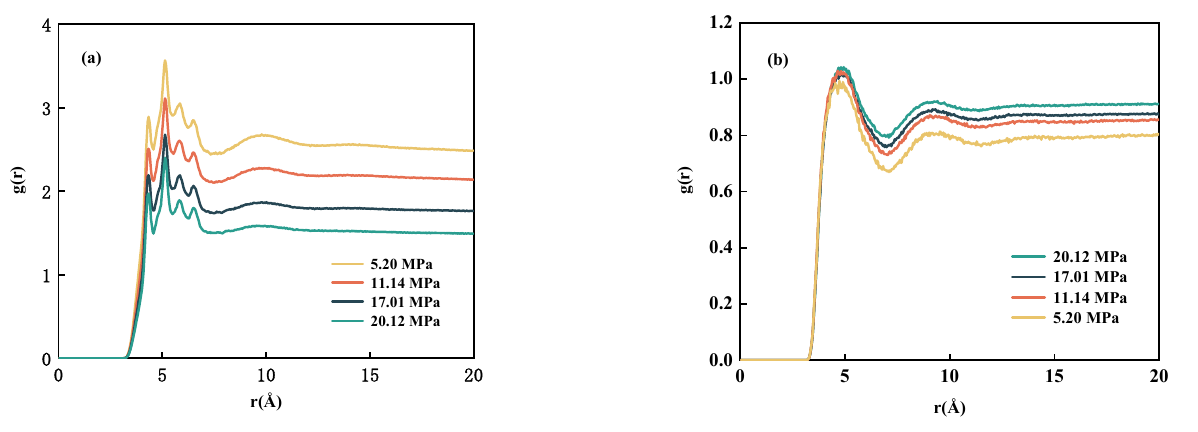
Figure 11. Radial distribution function of n-decane/CH 4 (313.3K). ( a ) N-decane-n-decane; ( b ) n-decane-CH 4 .